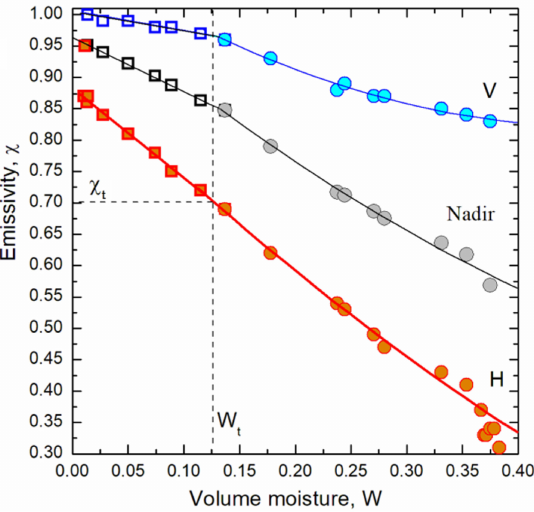
Figure 3. Dependence of emissivity ( χ ) on volume fraction of water in soil